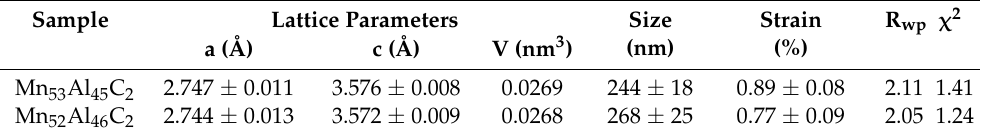
Table 1. Lattice parameters, average crystal size of the τ -phase, and microstrain for the samples annealed at 700 ◦ C. R wp and χ 2 (goodness of fit) are also provided.